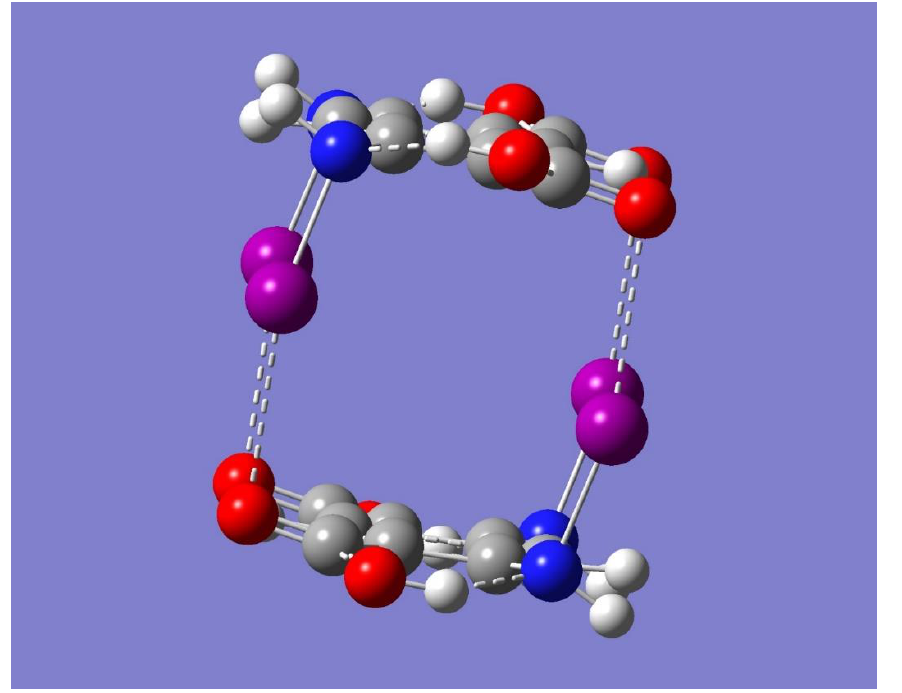
Figure 3. Optimized geometry of the ((HOOC) 2 -C 6 H 2 -(NHI) 2 ) dimer. Intramolecular OH…N hydrogen bonding and intermolecular NI…O=C halogen bonding indicated with respective dashed lines. Individual atoms can be distinguished by color: C (grey), H (white), N (blue), O (red), and I (purple).